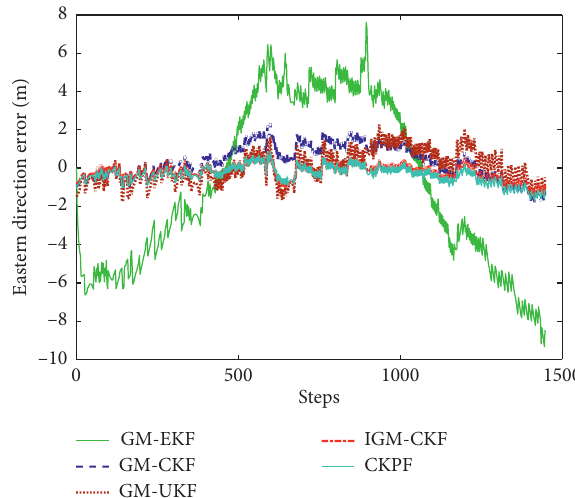
Figure 4: Comparison of the eastern direction